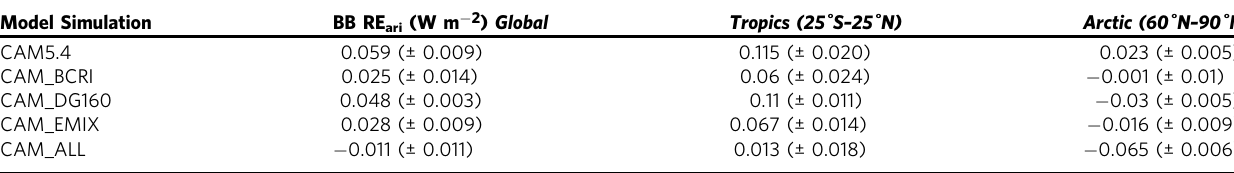
Table 2 The radiative effect due to aerosol-radiation interactions (RE ari ) of biomas burning (BB) aerosol in the CAM5.4 sensitivity tests. The CAM5.4 sensitivity tests are for different BB aerosol treatments: default CAM5.4 (CAM5.4), CAM5.4 with decreased BB black carbon refractive index (CAM_BCRI), CAM5.4 with increased BB aerosol size (CAM_Dg160), CAM5.4 with externally mixed, fresh BB aerosol (CAM_EMIX), and CAM5.4 with all of the previous changes (CAM_ALL). These RE ari are considered over the entire globe, the tropics, and the Arctic. Standard deviations from the 5 ensemble means are